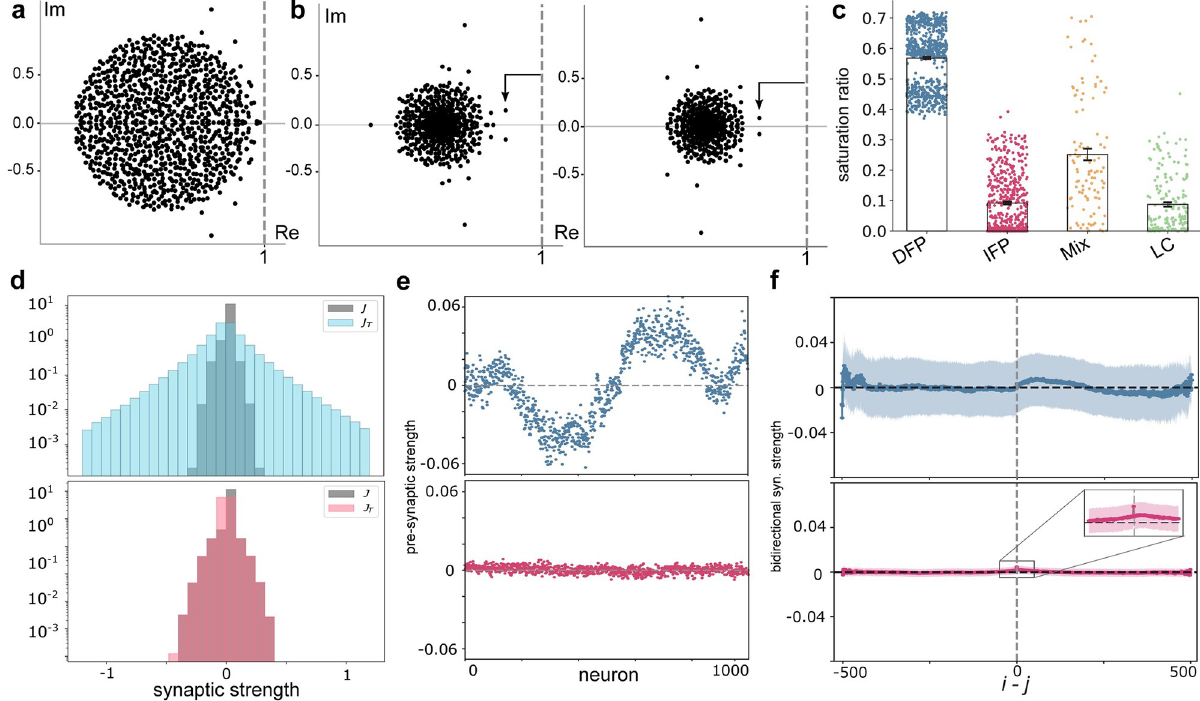
Fig 4. Eigenvalue spectrum at task fixed points and connectivity characterization. a , Eigenvalue spectrum of Jacobian matrix at the single non-zero stable fixed point of IFP (shown in Fig 2b). b , Eigenvalue spectra of the Jacobian matrix computed at memory fixed points of DFP, wherein the network uses two fixed points to encode memory representations associated with stimulus 1 and stimulus 2. (shown in Fig 2a). c , Saturation ratio (the ratio of neurons with activity in saturated range of activation function during memory interval (averaged over all trials)) for all networks simulated (across all four mechanisms). Standard error of the mean is depicted. d , Distribution of connectivity matrix entries (i.e., weights) before and after training for DFP (the top panel) and IFP (the bottom panel). J and J T denote connectivity matrix before and after training, respectively. e , Average pre-synaptic (incoming connections) strength sorted by peak activation of neurons (as in Fig 1c) for DFP and IFP, respectively. f , Comparison of mean and variance of elements of task connectivity matrix based on temporal distance of neurons. For IFP (the bottom panel) temporally adjacent neurons are more tightly coupled and a peak can be observed. (The inset shows this peak and i , j denote neurons